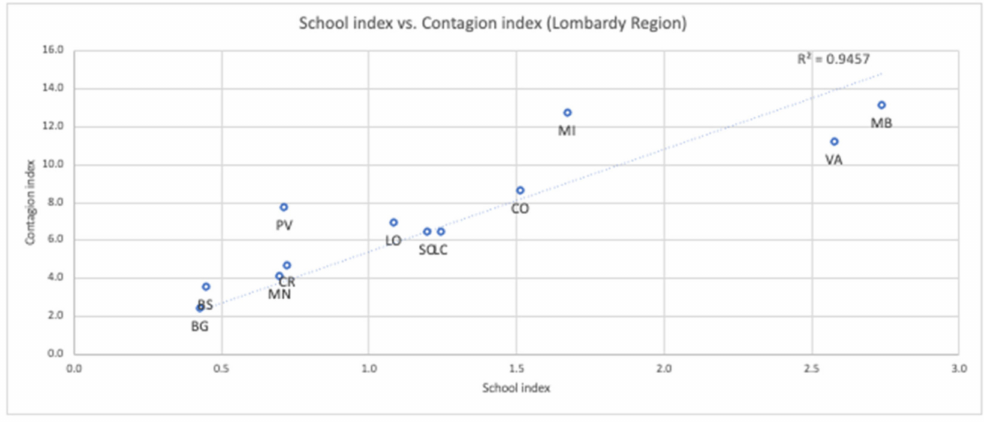
Figure 3. Lombardy Region scatter plot for school contagion index vs. overall contagion